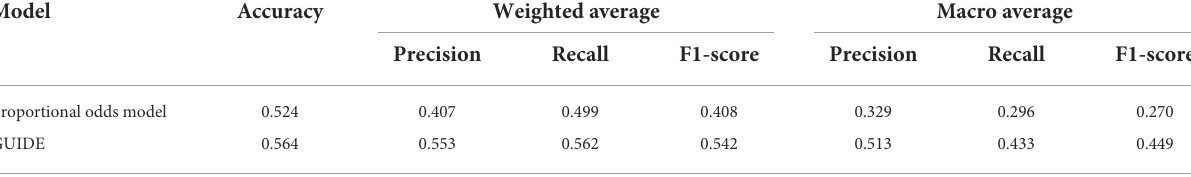
TABLE 3 Predictive models and performance for 4-group classification in testing